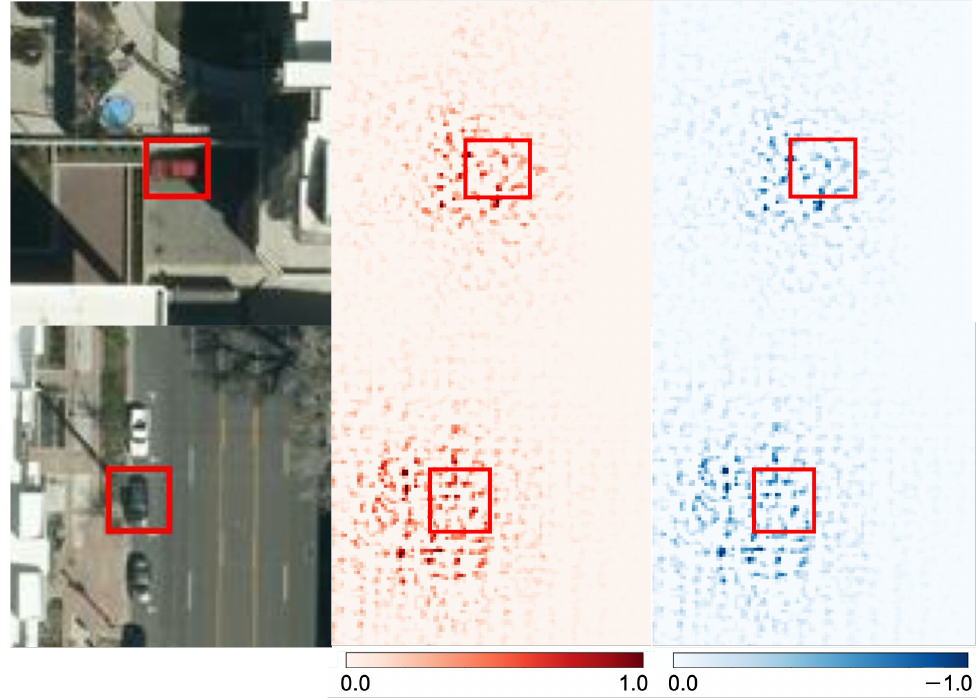
Figure 8. Visualization results of false-negative outputs by pixel-wise Gradient SHAP. The left image shows the inferred results, the center image shows the distribution of positive values, and the right image shows negative